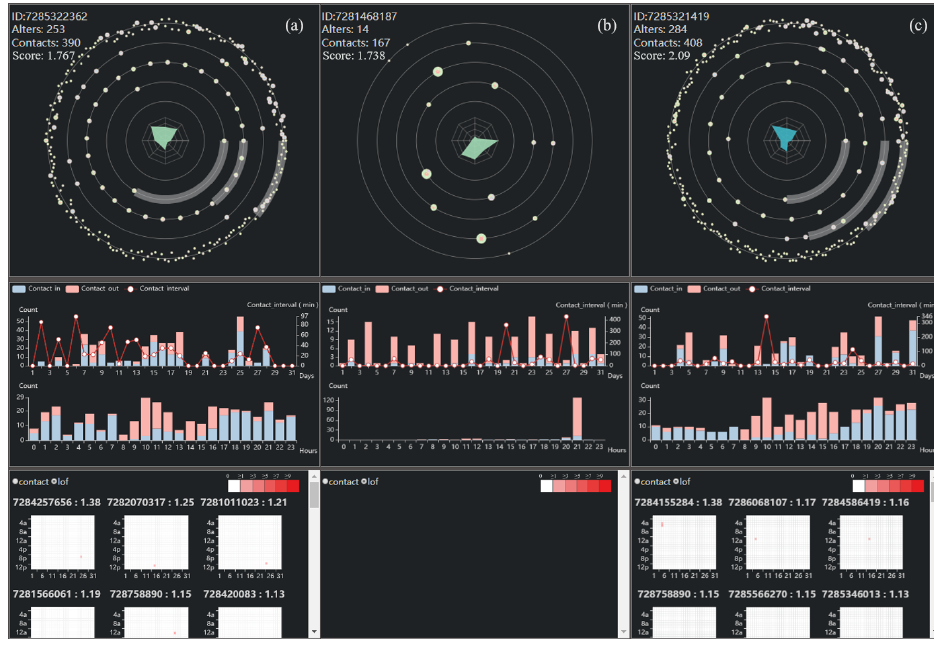
Figure 10. Some examples; ( a ) is the ego who cannot be judged directly by ego view, ( b ) is the ego who is misclassified, ( c ) is the ego who intends to disguise as a noraml one, but actually is an anomlous